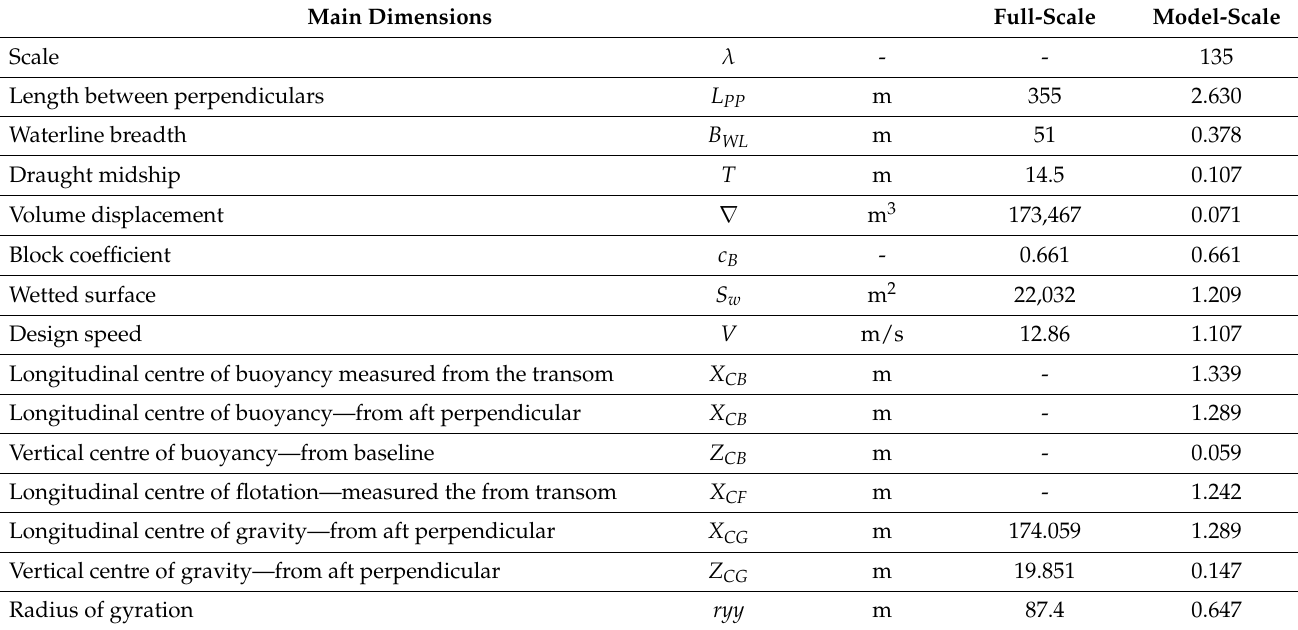
Table 1. Main hull characteristics.